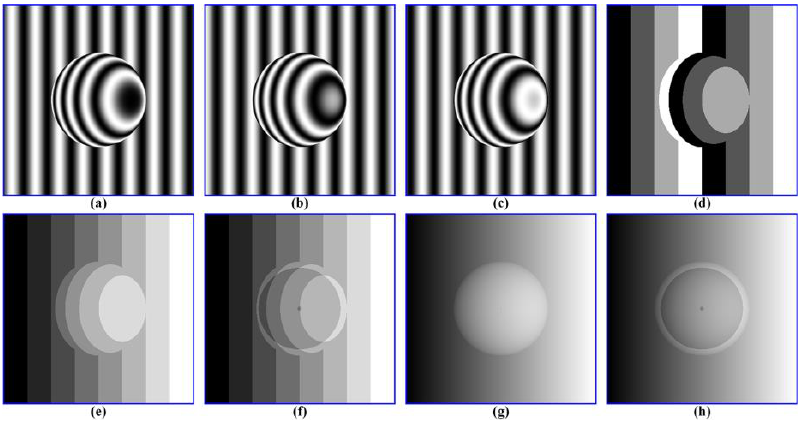
Figure 7. Simulation of a hemisphere. ( a – c ) Phase-shift patterns; ( d ) coded pattern; ( e ) fringe order map using the proposed method; ( f ) f ringe order map using An’s method; ( g ) absolute phase map using the proposed method; ( h ) a bsolute phase map using An’s m ethod.